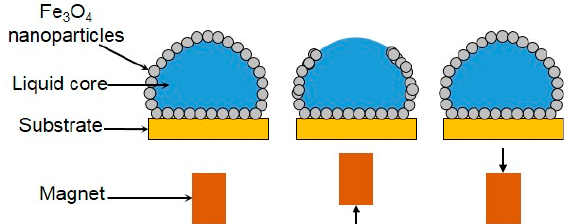
Figure 20. Sketch of magnetic manipulation of LMs coated with Fe 3 O 4 nanoparticles. From left to right, the Fe 3 O 4 nanoparticles are concentrated downwards when a magnet is brought into